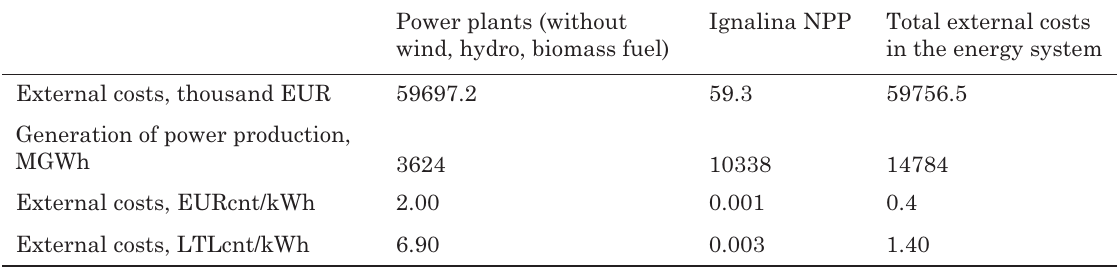
Table 2. External power generation costs in Lithuania in 2005, thousand EUR Power plants